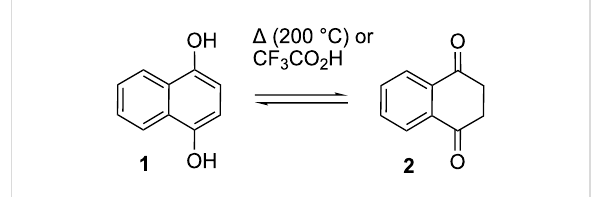
Scheme 1: Tautomerization of 1,4-dihydroxynaphthalene.